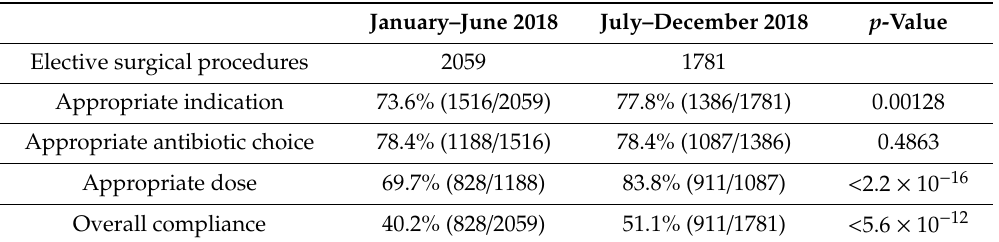
Table 2. Results of elective surgical procedures for 3 SAP parameters of appropriateness: indication, choice,